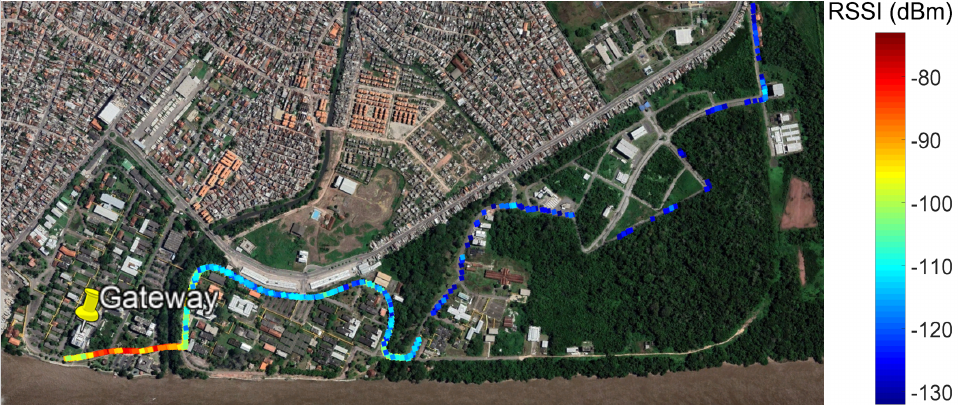
Figure 8. Route with measured data with location and RSSI